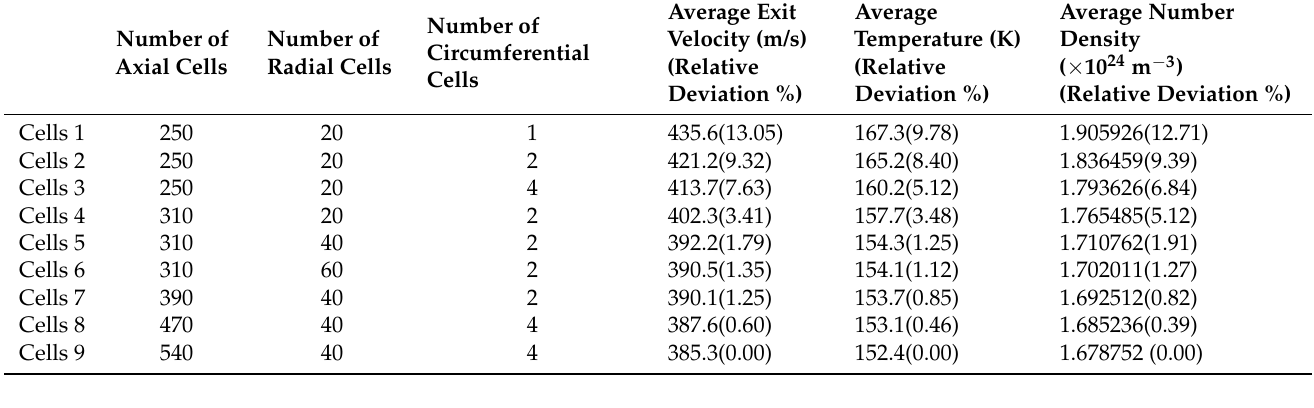
Table 1. Effects of cells on the mean molecular velocity at the nozzle exit.